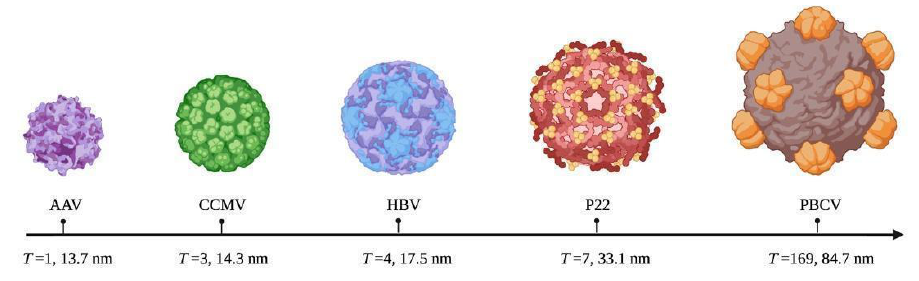
Figure 4. Several triangulations and diameters of viral entities. AAV, adeno-associated virus; CCMV, cowpea chlorotic mottle virus; HBV, hepatitis B virus; P22, bacteriophage; and PBCV, Paramecium bursaria Chlorella virus.